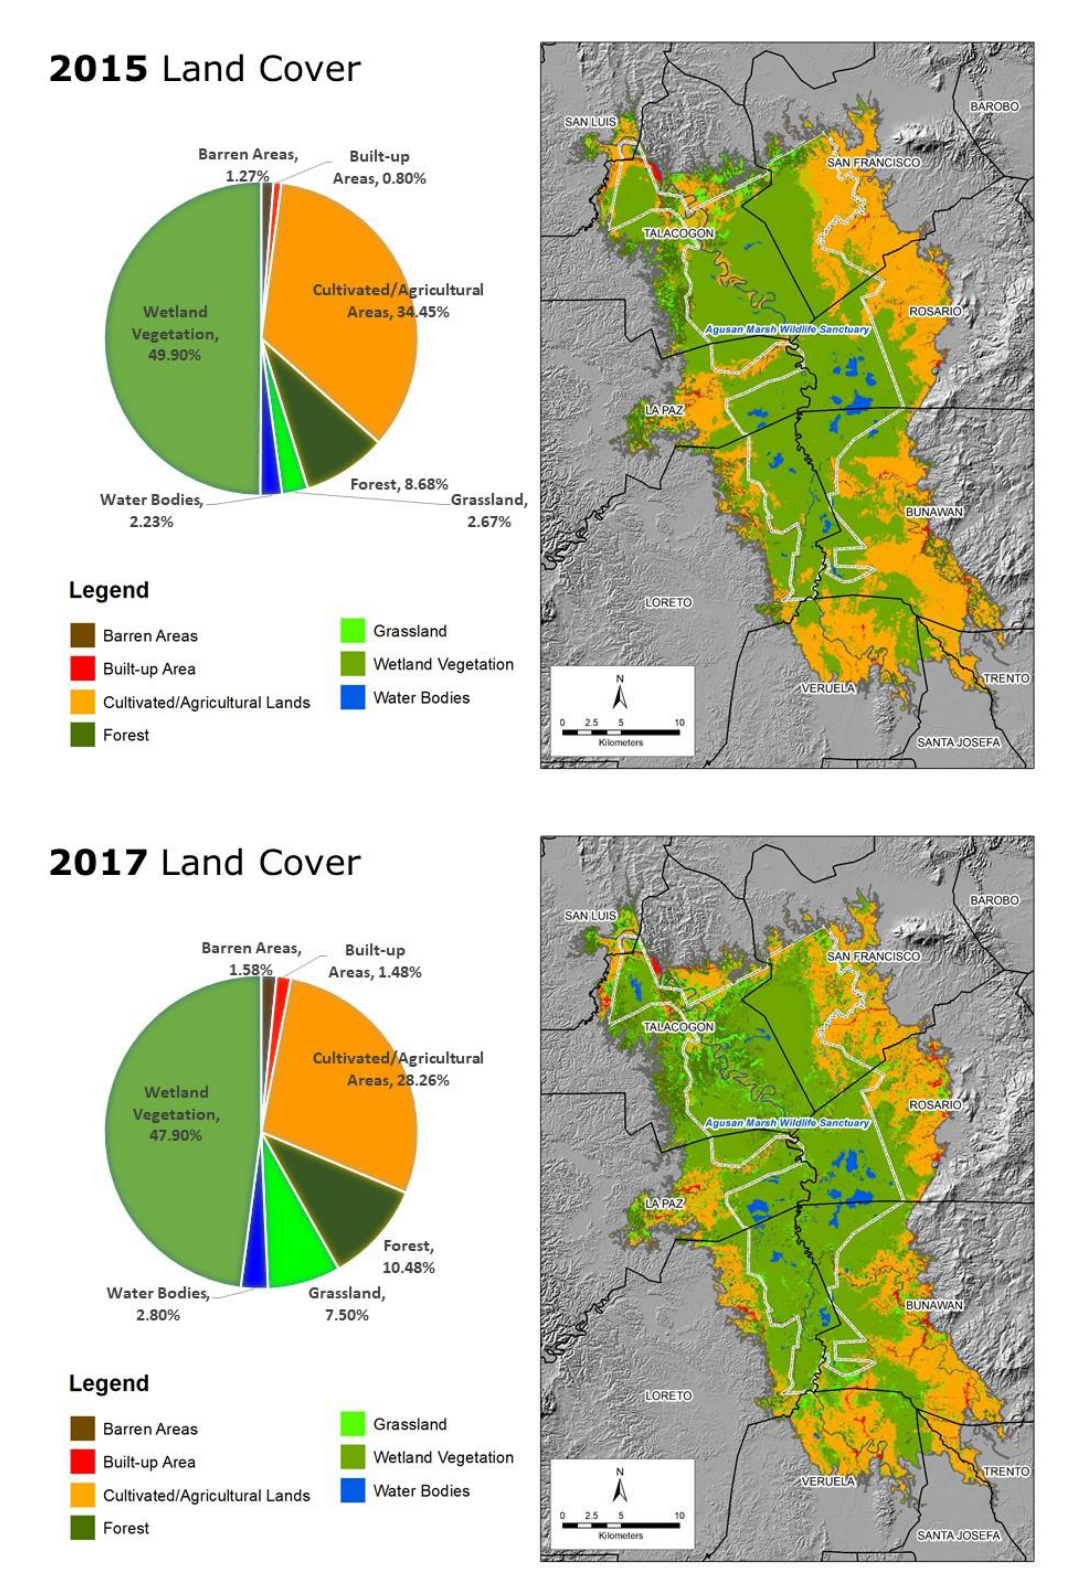
Figure 6 . Land-cover maps and statistics of the Agusan Marsh derived from multi-temporal Landsat images for the years 2015 and